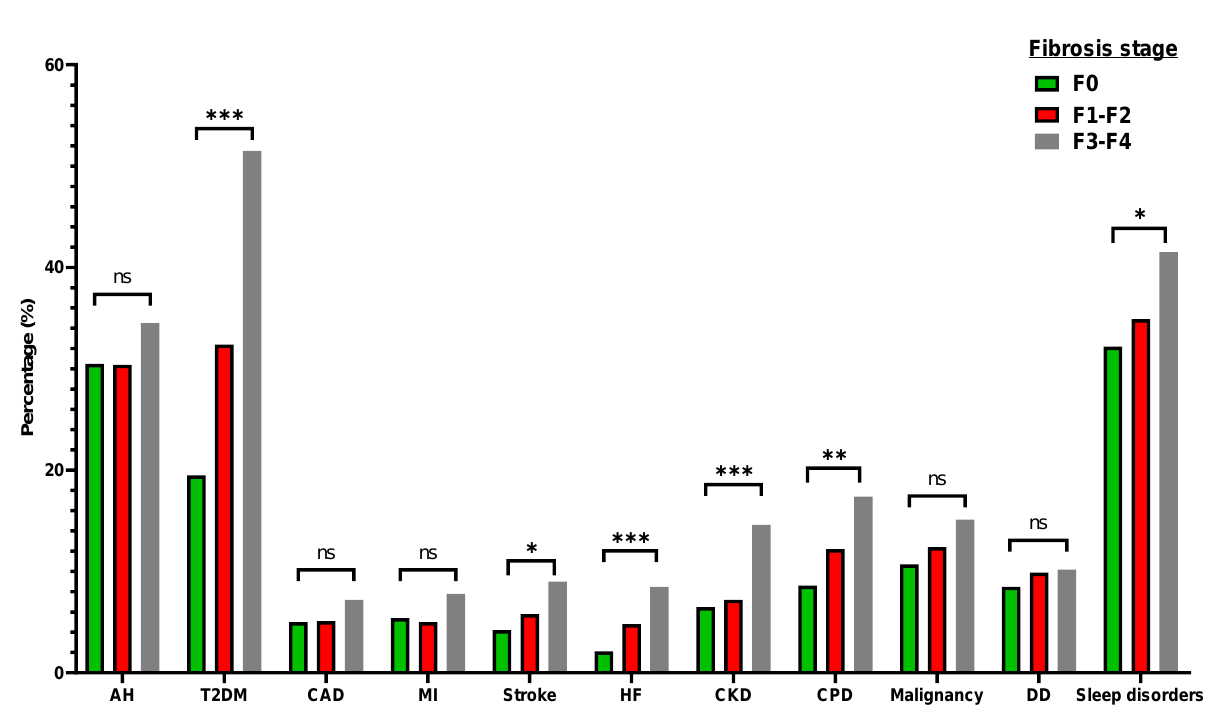
Figure 3. Differences in the prevalence of various pathologic states according to the fibrosis stage in individuals with metabolic dysfunction-associated fatty liver disease (MAFLD). AH: arterial